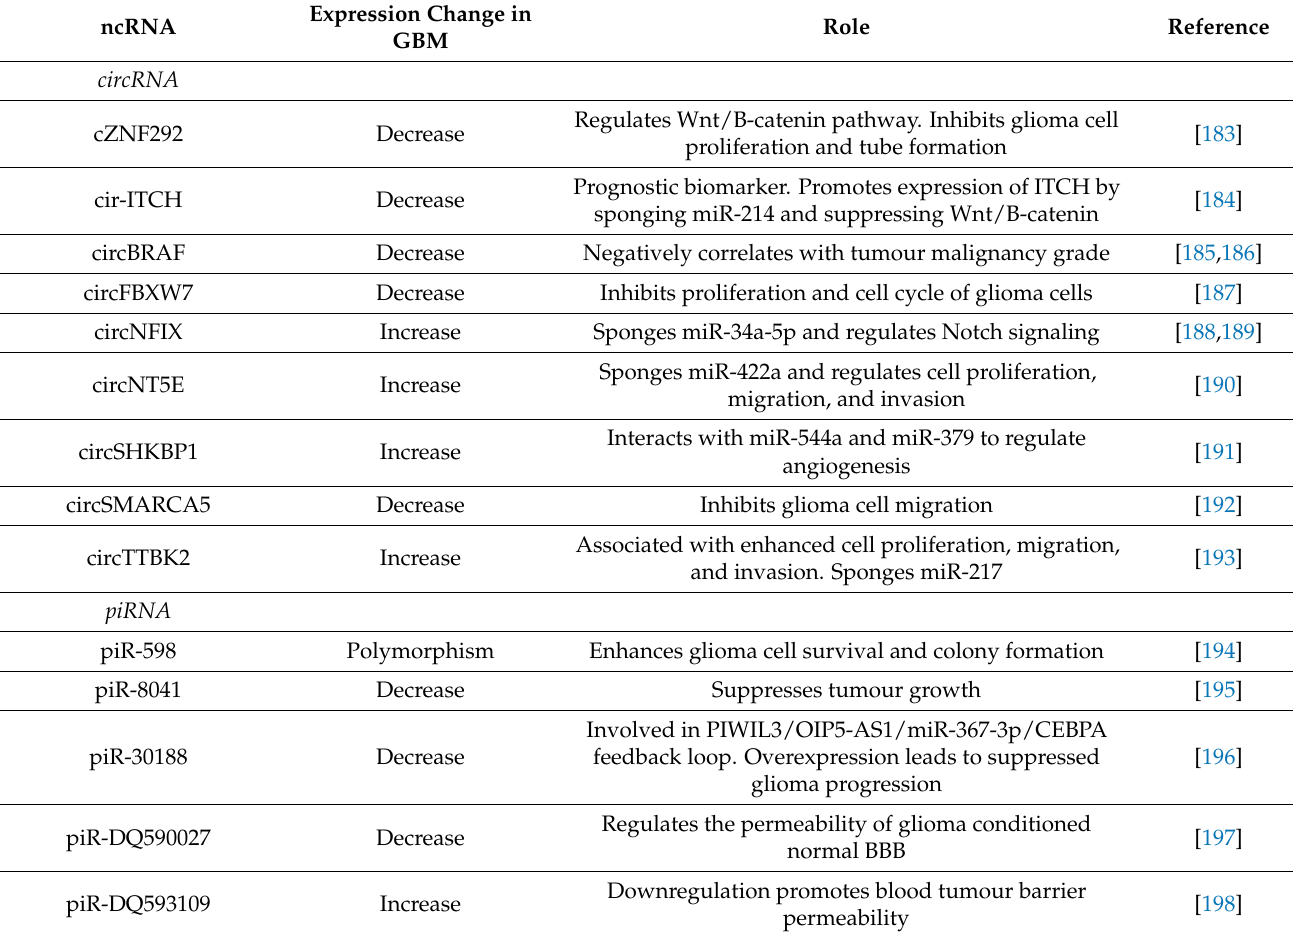
Table 2. Key functional circular RNAs (circRNAs) and piRNAs in